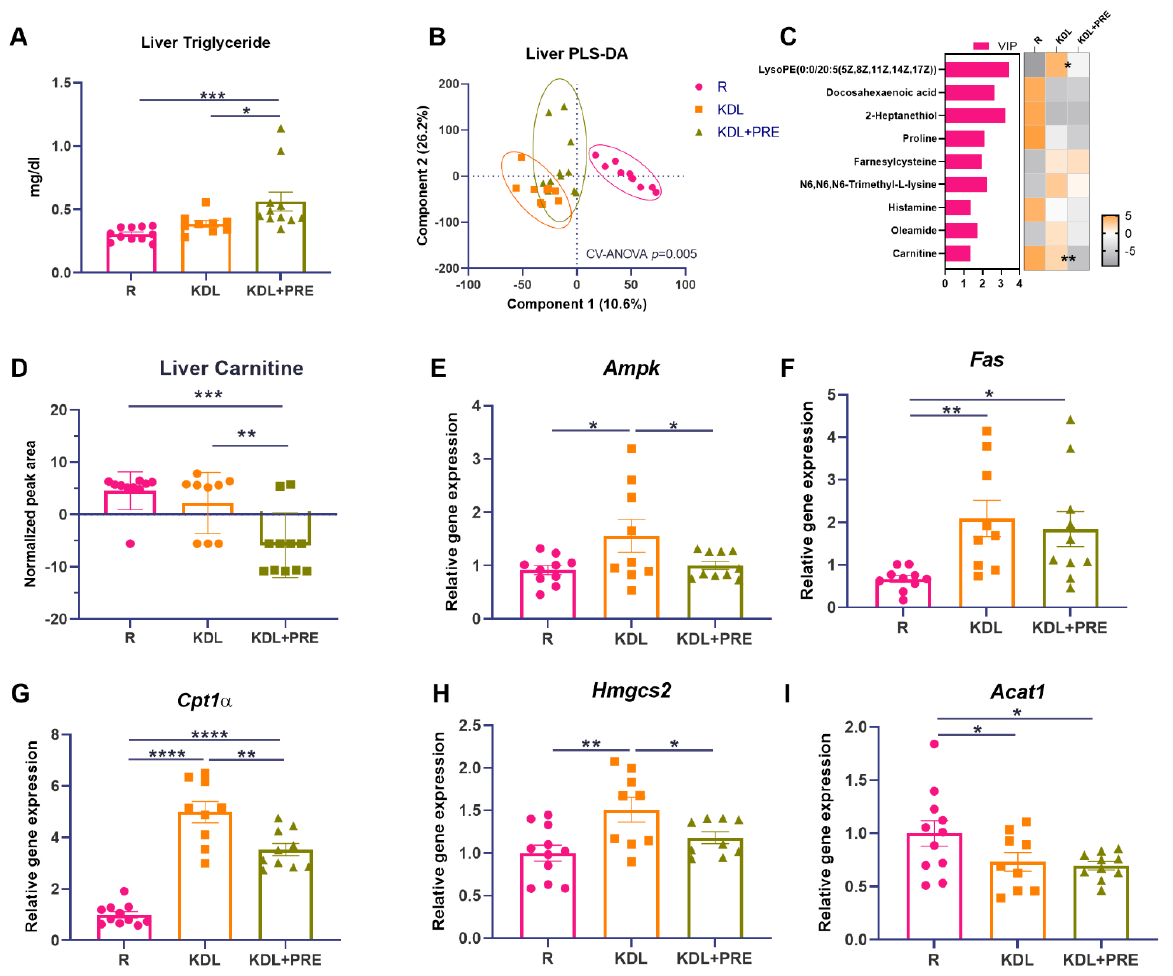
Figure 3. Effects of the prebiotic inclusion on liver metabolism. ( A ) Liver triglyceride. ( B ) PLS-DA analysis of liver metabolites. ( C ) Discriminant metabolites with p < 0.05 and VIP > 1 in the liver. In the heatmap, * p < 0.05, ** p < 0.01 comparing KDL vs. KDL+PRE. ( D ) Liver carnitine. ( E – I ) Gene expression of enzymes related to lipid metabolism in the liver. Data are presented as mean ± SEM with individual values. Acat1 -acetyl-CoA acetyltransferase 1; Ampk -AMP-activated protein kinase; Cpt1 α -carnitine palmitoyltransferase 1A; Fas -fatty acid synthase; Hmgcs2 -3-Hydroxy-3- Methylglutaryl-CoA synthase 2; R-normally developing reference group; KDL-ketogenic diet formula; KDL+PRE-ketogenic diet formula plus prebiotic fiber. n = 9-11 rats/group. * p < 0.05, ** p < 0.01, *** p < 0.001, **** p < 0.0001.